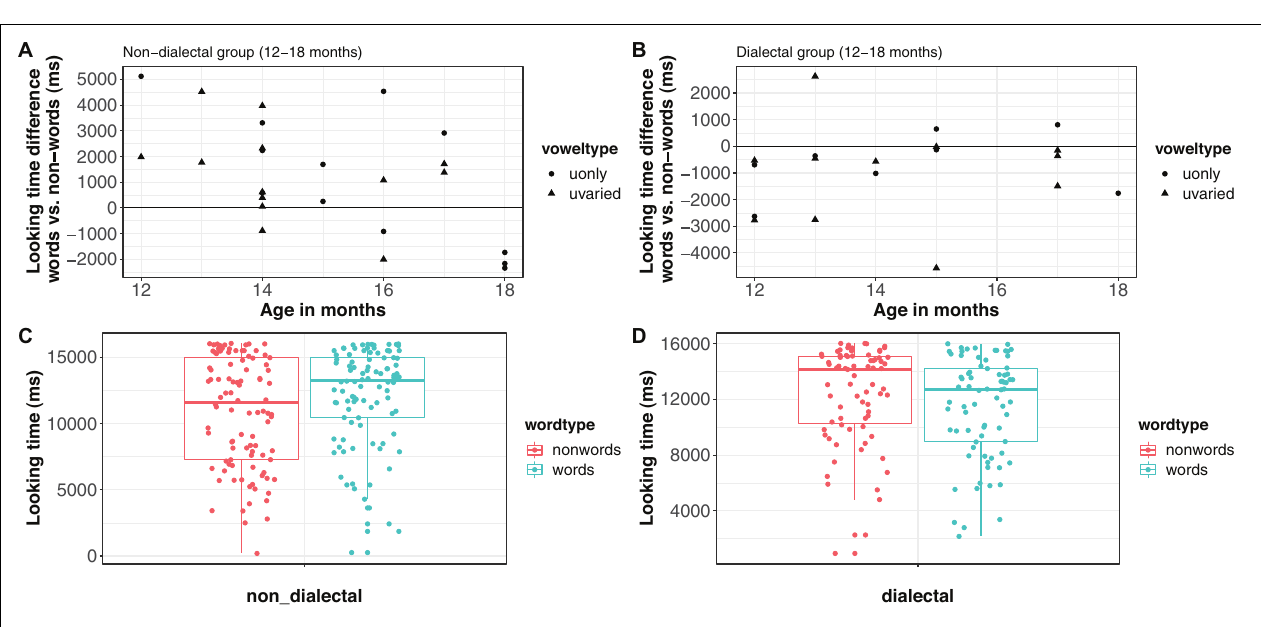
FIGURE 5 | Looking time difference between words and nonce-words in Experiment 1 [ (A,B) : each dot represents the average of one child] and looking times by word type [ (C,D) : each dot represents one trial]. Left panels: non-dialectal children, right panels: dialectal children.